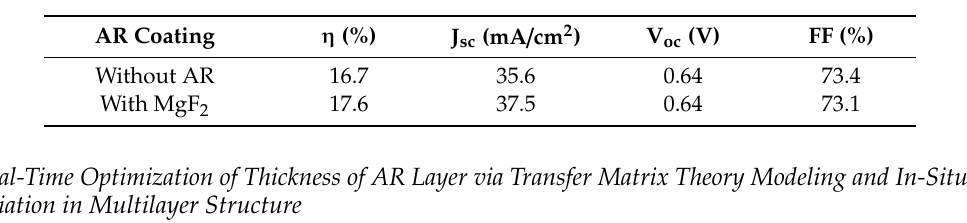
Figure 6. Comparison of measured ( a ) current–voltage (J–V) characteristics under simulated 1-sun illuminations and ( b ) QE spectra obtained for CIGS solar cells with and without the AR coating. Table 1. Device parameters of the CIGS solar cell before and after depositing the AR coating.